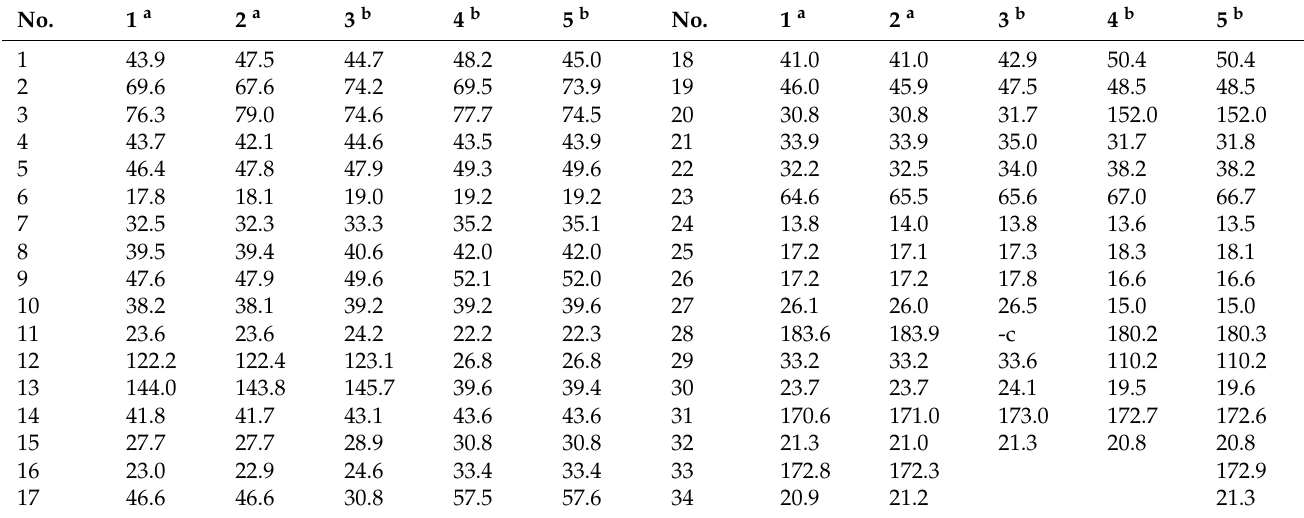
Table 2. 13 C NMR spectroscopic data of 1 – 5 measured at 125 MHz.